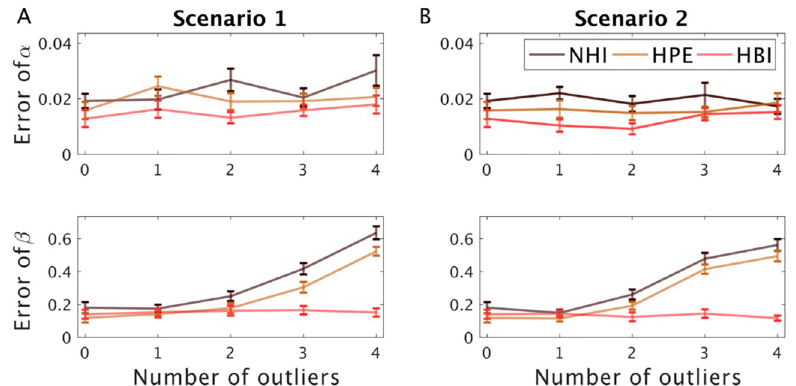
Fig 7. The sensitivity of parameter estimation to outliers. 30 subjects are simulated using the RL model. A) In scenario 1, a number of outliers are also simulated with the same learning rate but small decision noise parameter. B) In scenario 2, outliers are simulated with small learning rate and small decision noise parameter. Errors in recovering the group-level parameters are plotted (for the learning rate, and decision noise,). HBI performs better than alternatives. The estimation error is defined as the absolute difference between estimated group-level parameters and the true parameters. In all plots, error-bars are standard errors of the mean obtained across simulations 20 times.